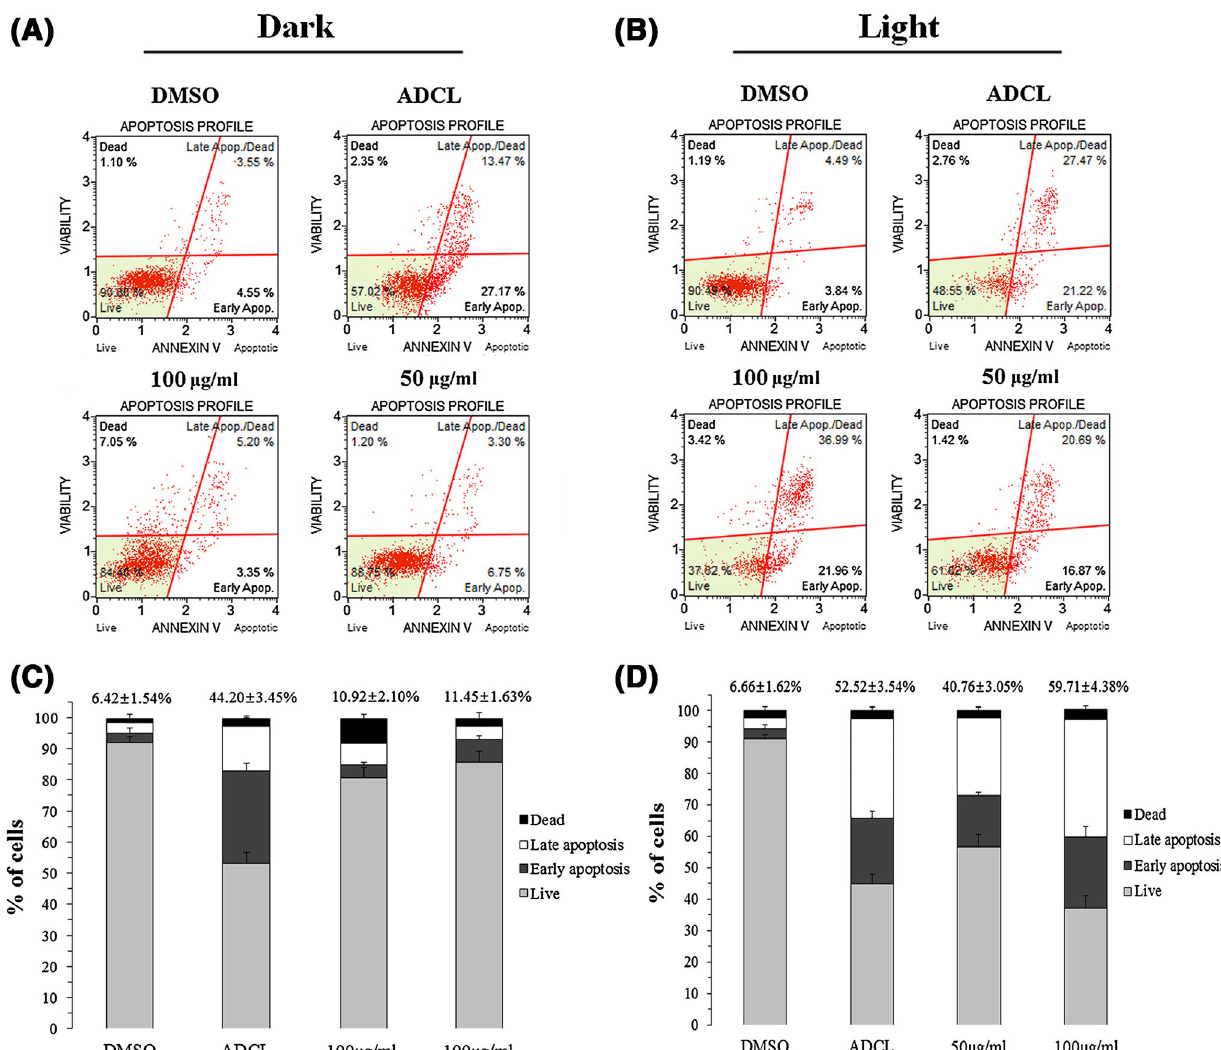
Fig. 6 SK-HEP-1 cells viability by BNCE treatment and light irradiation. Cells were treated with BNCE (50 and 100 l g/ml) for 4 h. Irradiated with light for 10 min or kept in the dark, followed by incubation for 6 h. Cells were stained with Muse TM Annexin V and Dead cell kit for 20 min and analyzed using a Muse TM Cell